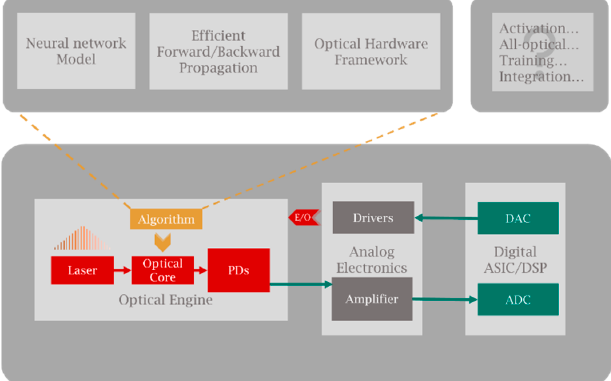
Figure 3. A possible framework for optoelectronic-hybrid AI computing.